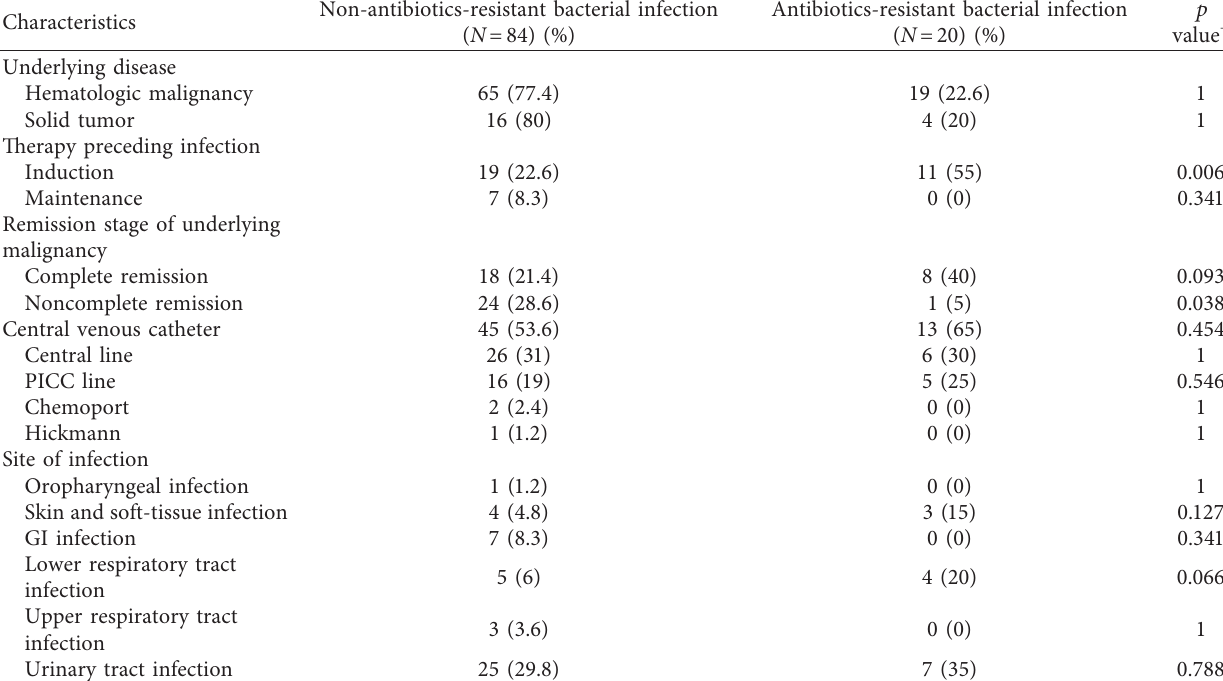
Table 6: Characteristics of febrile neutropenic children with Gram-negative bacterial infection.